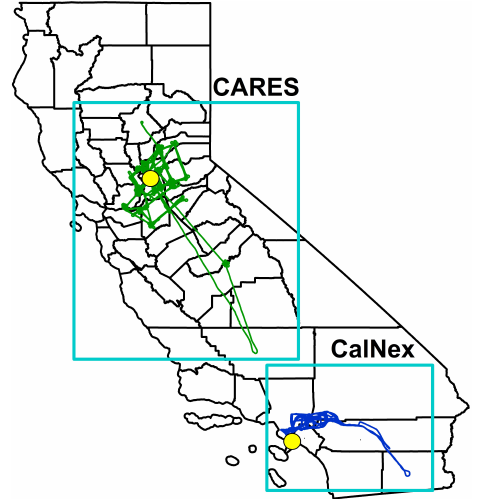
Fig. 1. Operational areas for CARES and CalNex. All flight paths are overlaid on each other. Yellow dots represent Sacramento (CARES) and Los Angeles